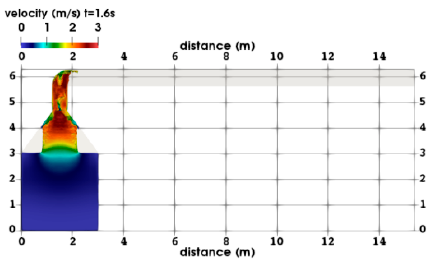
Figure 2. Experiment flume setup and dimensions (mm): ( a ) the slurry mixing device and storage tank; ( b ) the downstream flume; ( c ) the piezometer and data sampling system.